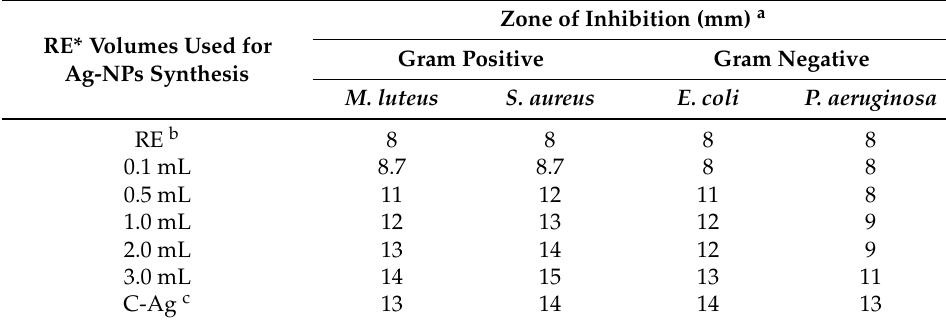
Table 1. Microbicidal activity of Ag-NPs synthesized with various volumes of root extract.